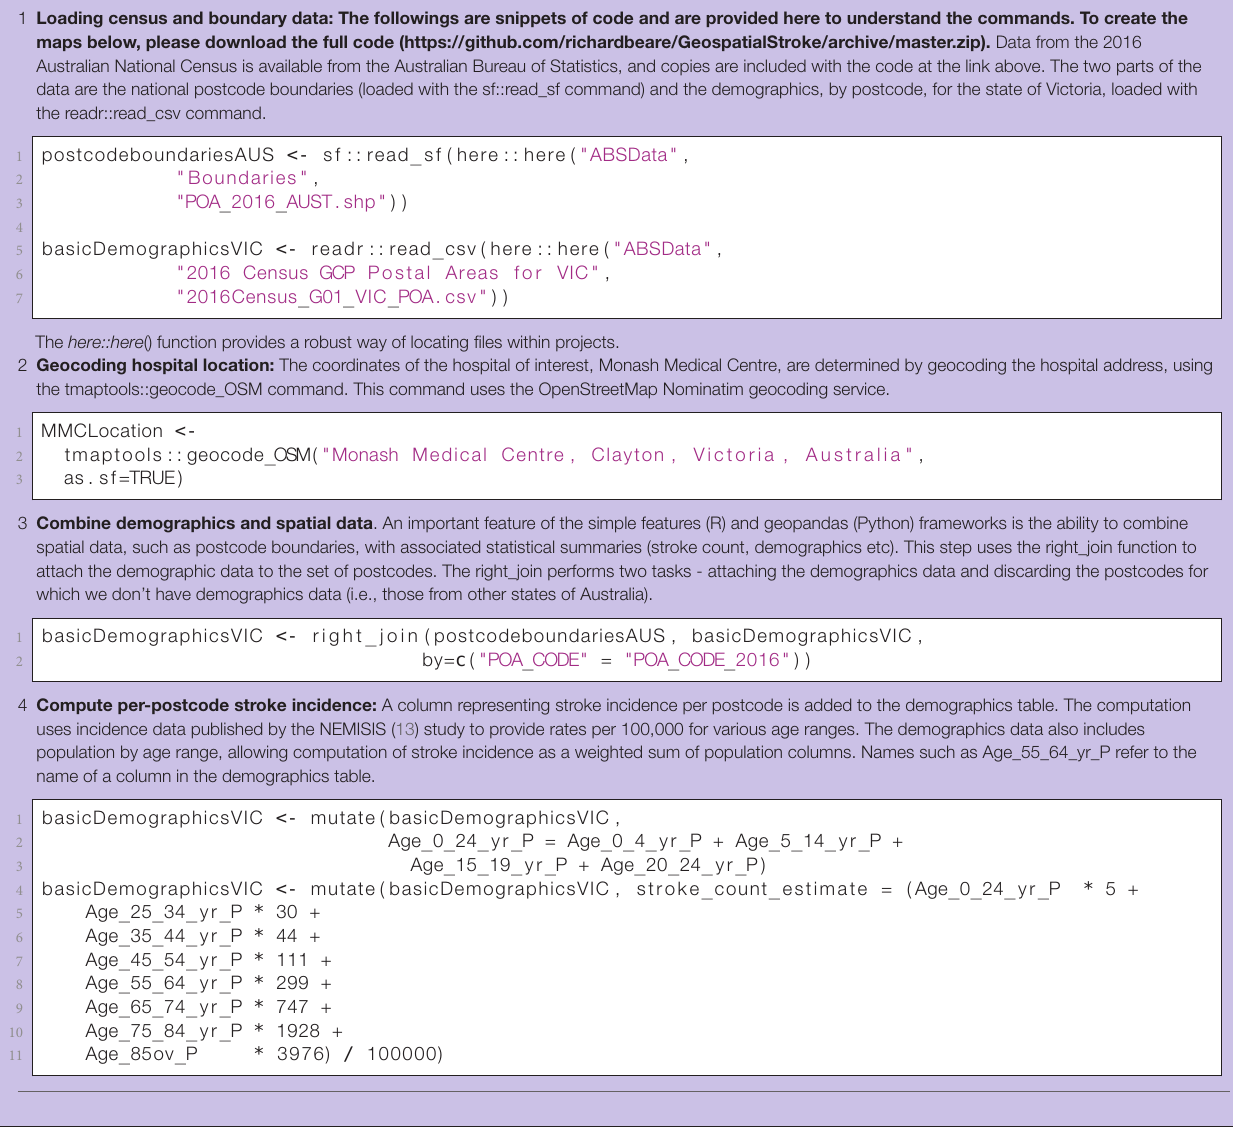
TABLE 1 | Steps 1-4 in computation of interactive display of choropleth of estimated stroke incidence. R code listings from the demonstration scripts is